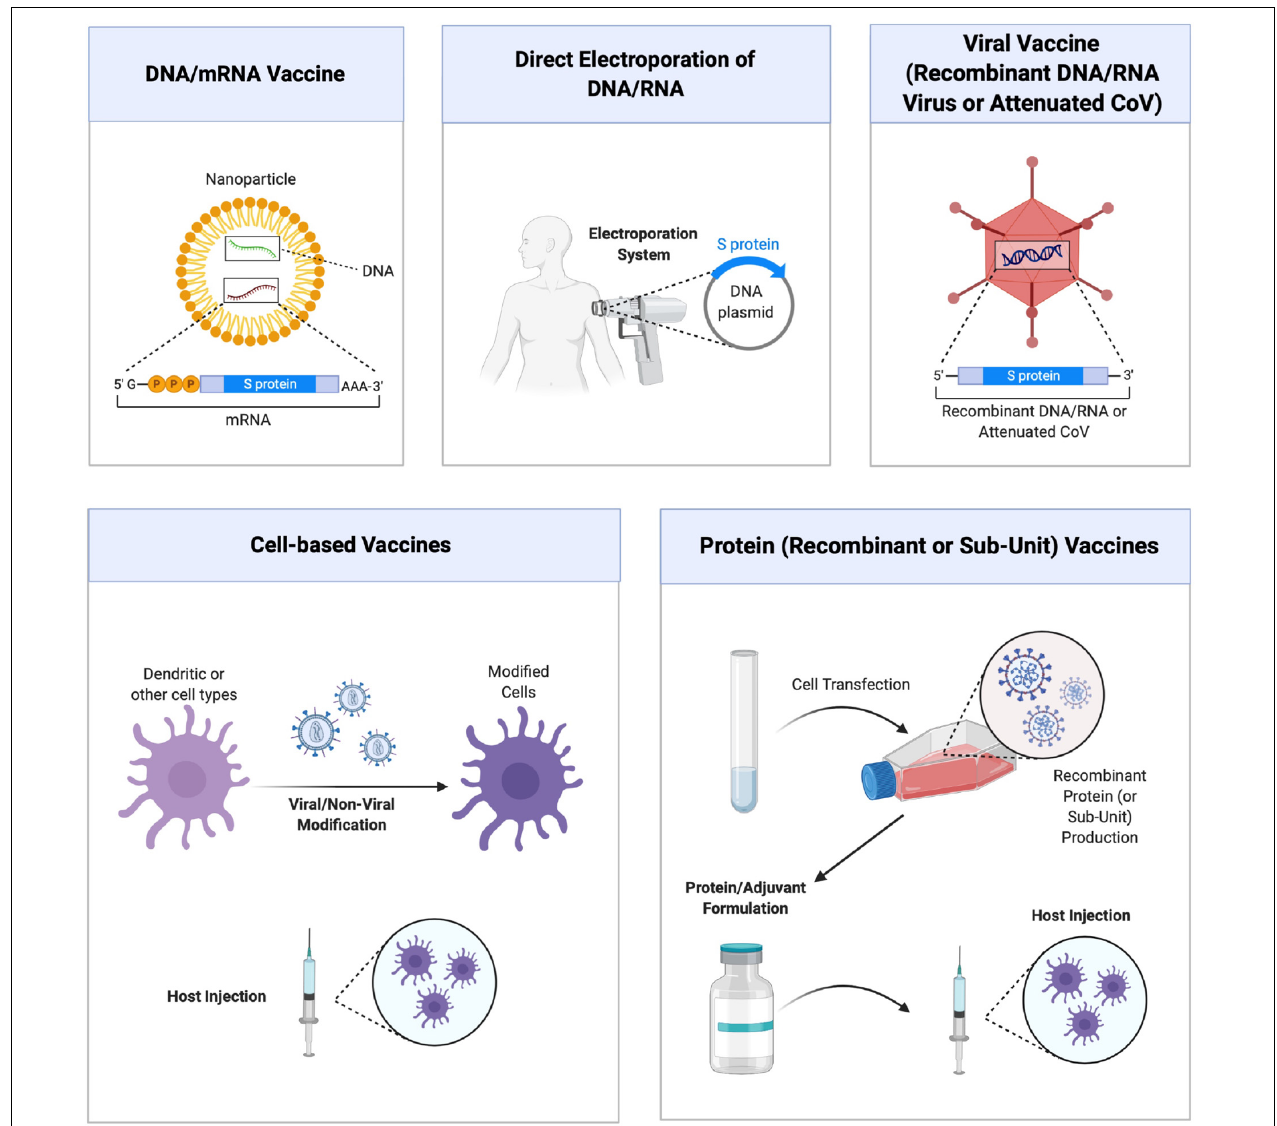
FIGURE 3 | Different approaches to vaccine development against COVID-19 disease. Main strategies are schematically shown, which relies on (from top left, clockwise) (i) nucleic acid (DNA and RNA) vaccines delivered with nanoparticulate carriers and coding for specific viral sub-units or virus-neutralizing agents, (ii) direct administration of DNA/RNA expression systems with forced expression, (iii) viral vaccines composed of recombinant or attenuated viruses, (iv) vaccines derived from recombinant viral proteins or purified sub-unit proteins, and (v) cell based vaccines relying of modification and administration of cells. Figure courtesy of